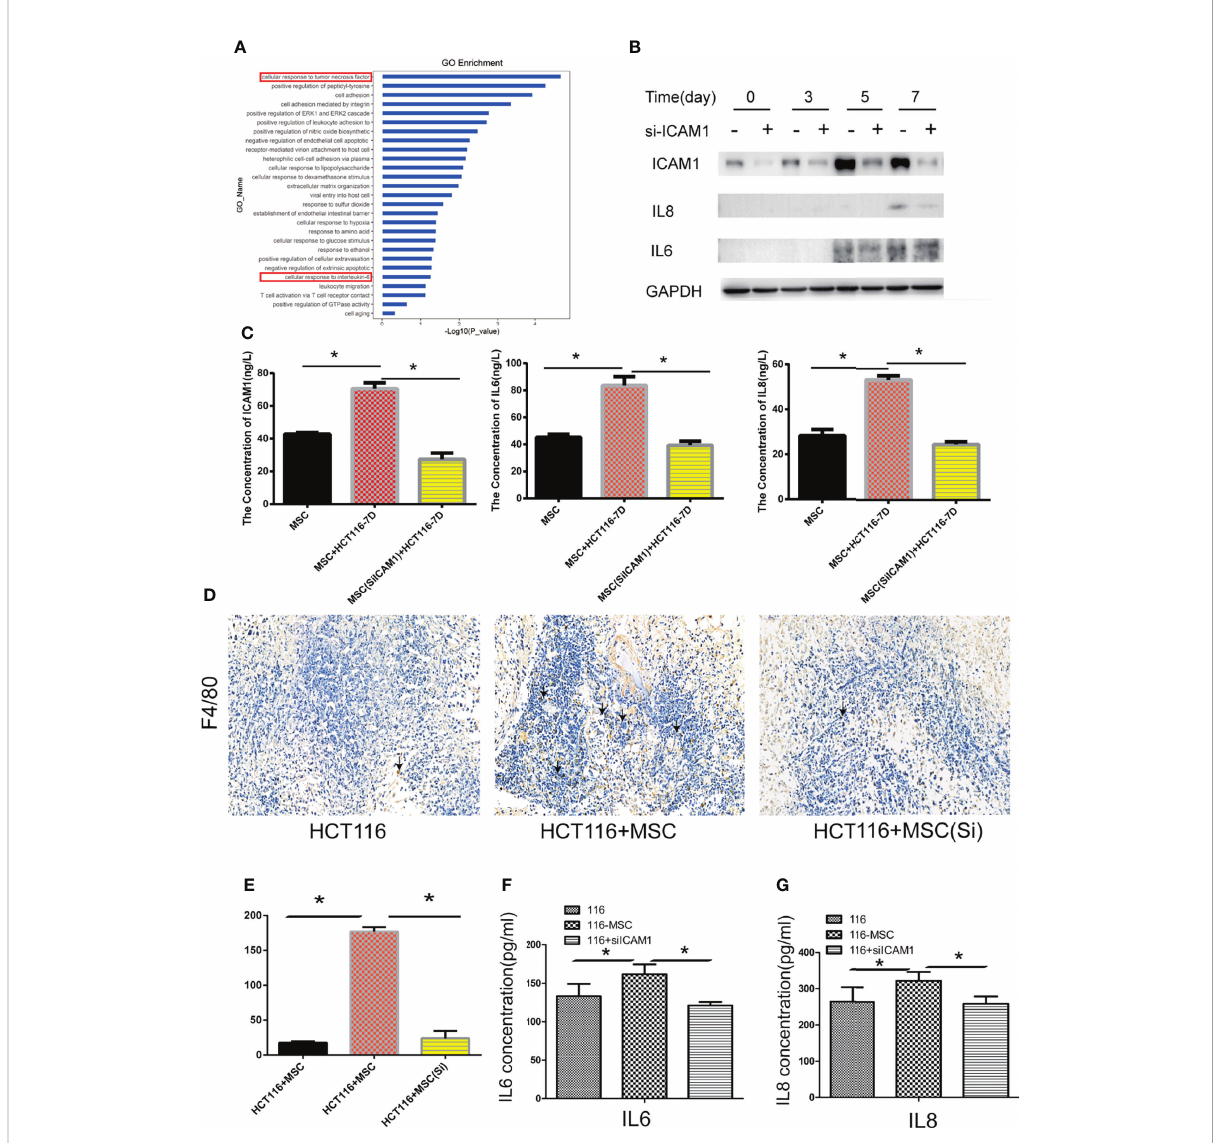
FIGURE 4 ICAM-1 mediates the in fl ammatory microenvironment. (A) Go enrichment analysis showed that in fl ammatory signaling pathways in MTCAF were signi fi cantly activated with the situation of H-Exos stimulation. (B) The expression of IL6 and IL8 was detected by Western blotting (WB) in MTCAFs or MTCAFs with knocking down ICAM1 at days 0, 3, 5, and 7. (C) ELISA detection detected the ICAM1, IL6, and IL8 expression from cellular supernatant with ICAM1 or without ICAM1. (D, E) Macrophage in fi ltration into tumor tissues was examined using immunohistochemistry for the detection of the F4/80. Representative images of F4/80 stainings for each group are shown (magni fi cation, ×400). Panel (E) shows the quantitative results. (F, G) IL-6 and IL-8 from mice serum levels were evaluated using ELISA in the three different groups (n = 5). *p<0.05, **p<0.01, and